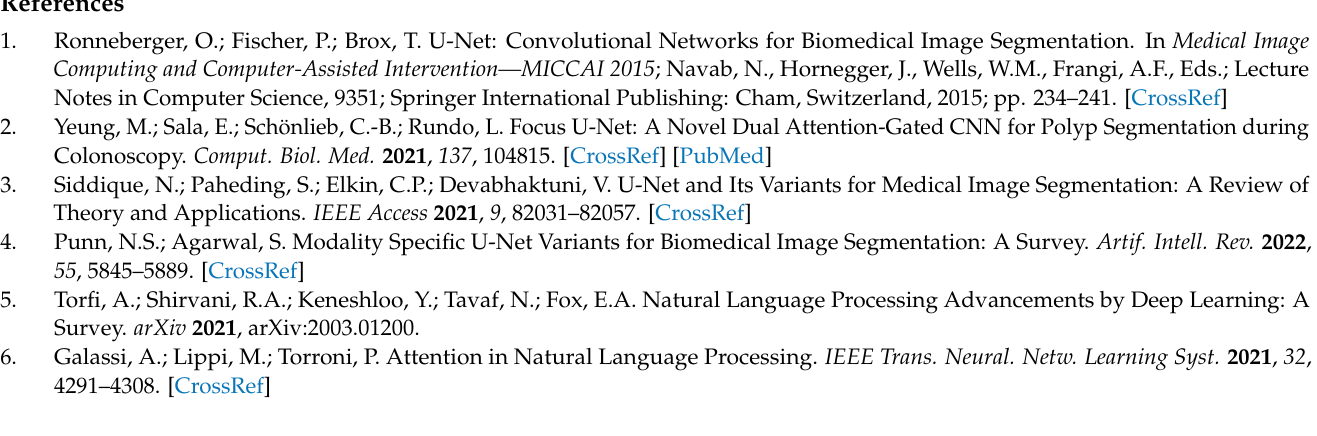
acquisition methods; Table S1: Table of enrolled subjects’ characteristics; Table S2: Table of enrolled subjects’ meningioma characteristics; Figure S1: Violin Plots of whole tumor volume; Figure S2: Dice score plots against binned whole tumor